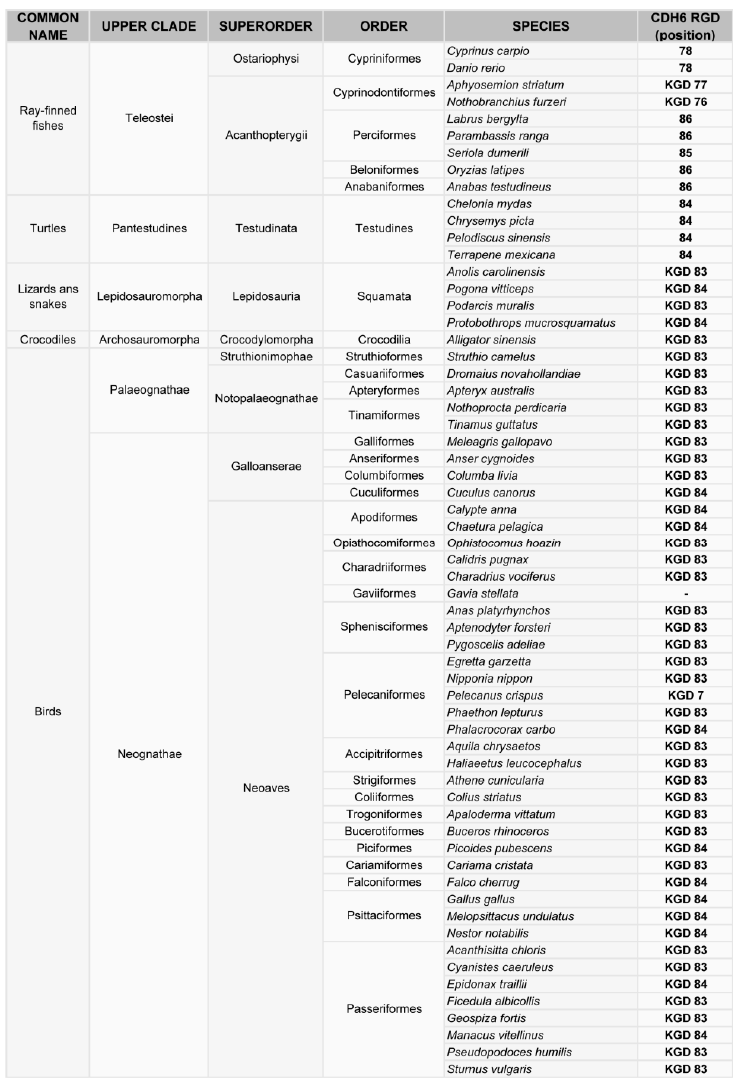
Figure 2. Phylogenetic analysis of the RGD motif in CDH6. Classification of vertebrates (excluding mammals) where the CDH6 gene has been sequenced, indicating the position of the RGD or KGD motif in the sequence. 331